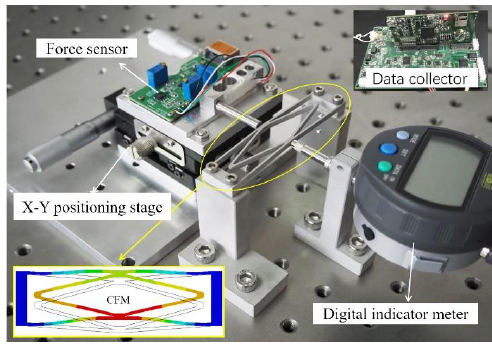
Figure 11. The experimental apparatus.